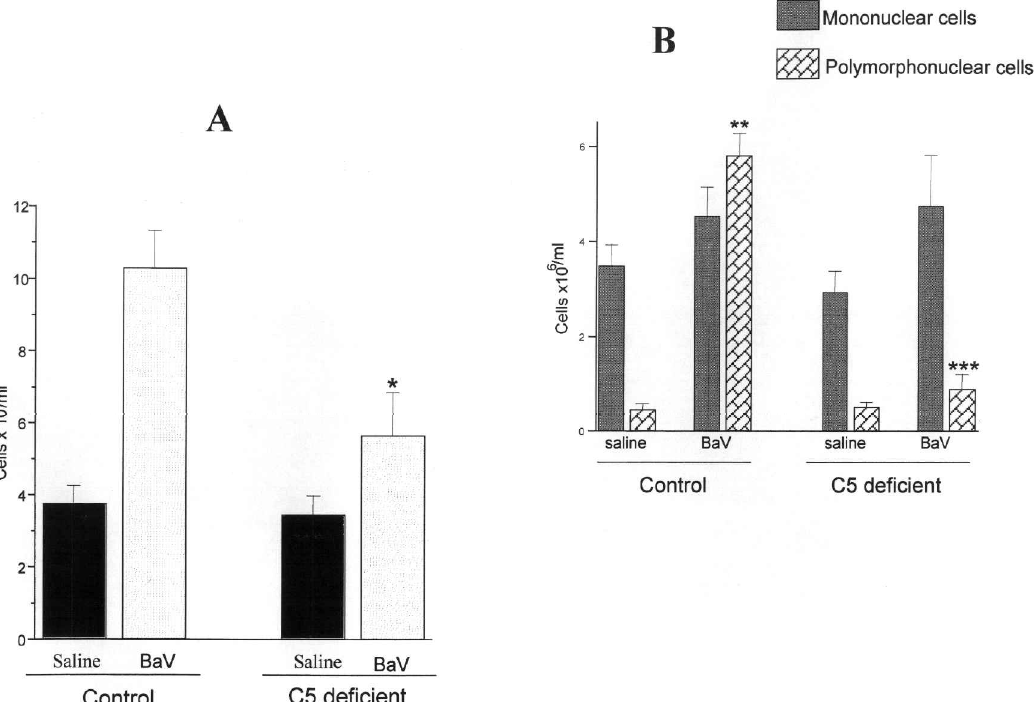
FIG. 6. Number of total (A) and differential (B) leucocytes migrated into the peritoneal cavity of male B10A (H–2 a ) or A/J (H–2 a ) mice 4h after intraperitoneal injection of 10 m g of Bothrops asper venom (BaV) dissolved in 1ml of sterile saline. Both groups of animals received venom or the equivalent volume of sterile saline. Values are mean ± standard error of the mean (SEM) of five animals in each group. * p < 0.01 versus values obtained in control animals treated with BaV, ** p < 0.001 versus values obtained in control animals treated with saline and *** p < 0.001 versus values obtained in control animals treated with